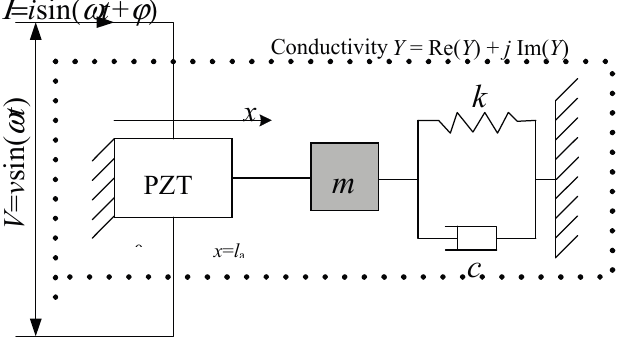
Figure 1. 1D model of PZT-structure coupled